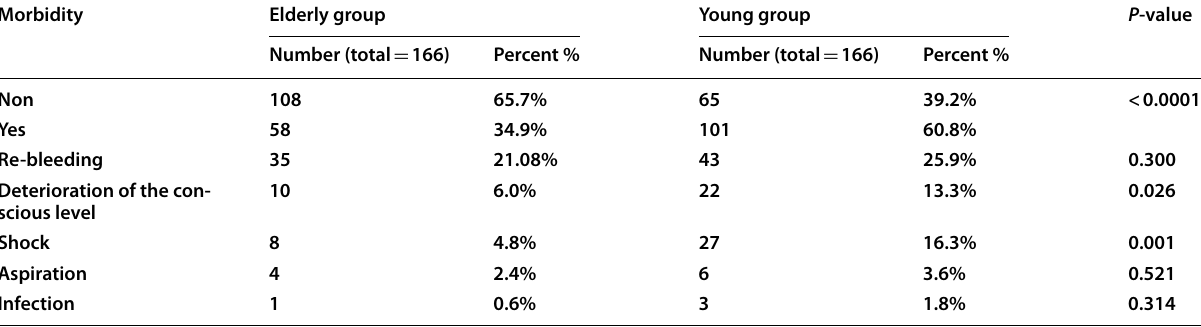
Table 6 Comparing morbidity between both groups